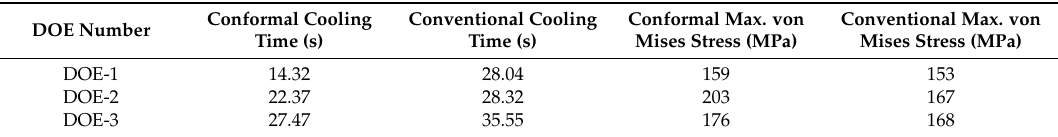
Table 6. Comparative thermal and structural results from DOE 1, 2 and 3 with conformal and conventional cooling channels.